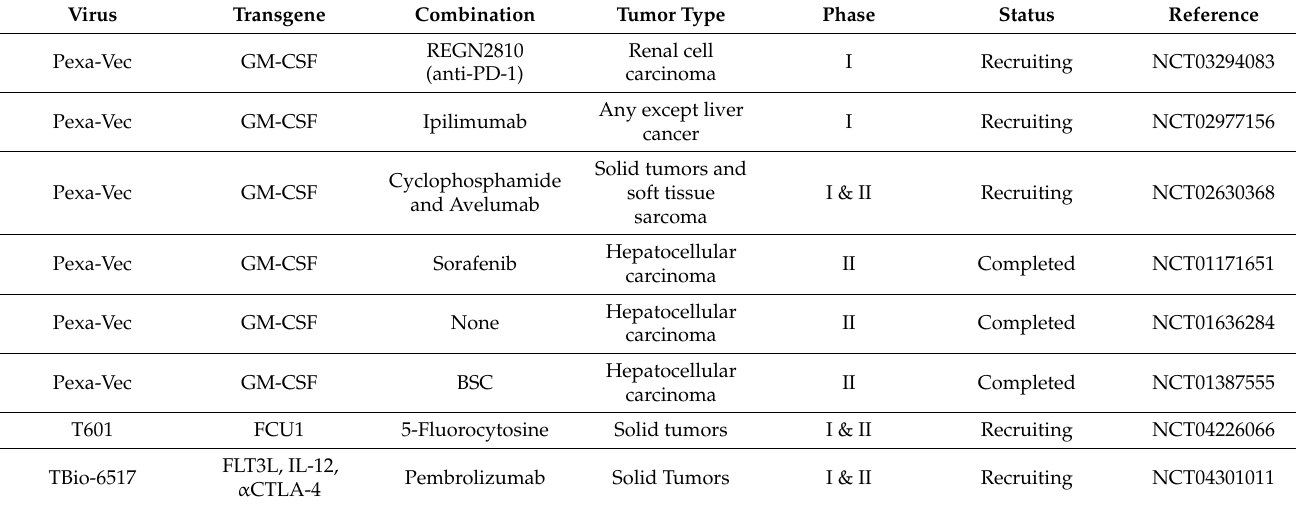
Table 2. Examples of oncolytic vaccinia viruses (VACVs) in clinical